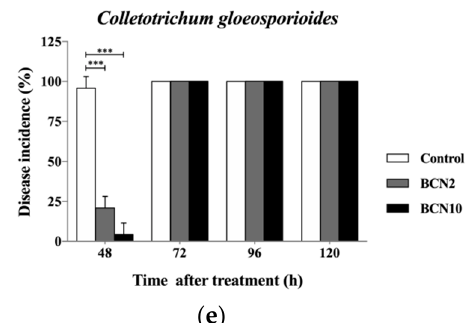
Figure 2. Disease incidence (percent of rotten fruits) of loquat fruit with the treatment of volatile organic compounds produced by two Bacillus strains. The loquats were artificially inoculated with Fusarium oxysporum (a), Botryosphaeria sp. (b), Penicillium expansum (c), Trichoderma atroviride (d), and Colletotrichum gloeosporioides (e) at 25 °C and 85% RH. * p <0.05, ** p <0.01, *** p <0.001 vs control, according to Tukey’s HSD test.